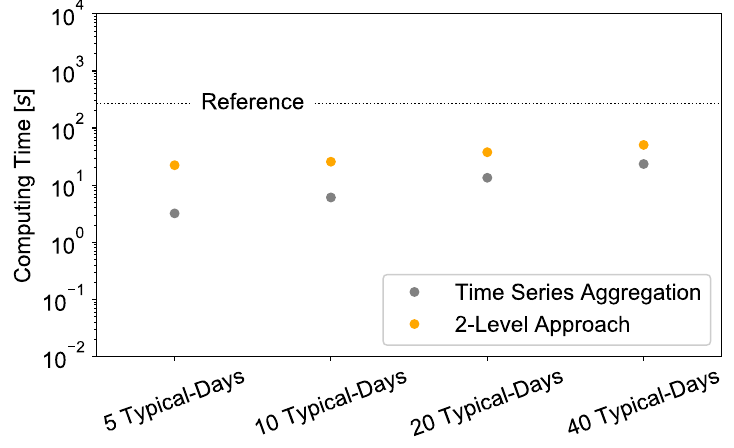
Figure 13. Comparison of the computing F igure 13. Comparison of the computing time.